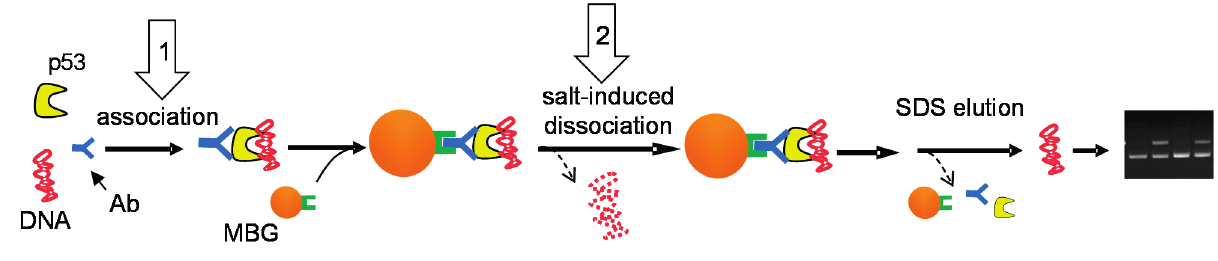
Figure 1. Scheme of the magnetic beads-based immunoprecipitation (MBIP) assay of